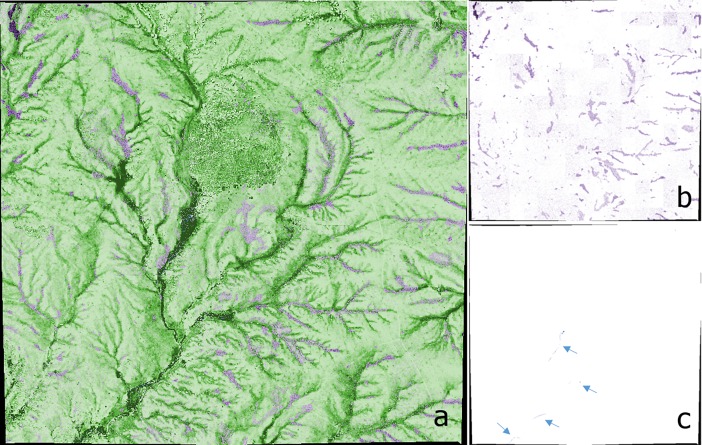
Model landscape, 1.66 km x 1.58 km.(a) Initialized full model landscape, with darker green indicating areas with greater aboveground forage biomass. (b) Landscape with larkspur locations only, with darker purple representing higher MSAL-content and with results of hybrid sampling method evident. (c) Landscape with watering locations only, pointed out by arrows.